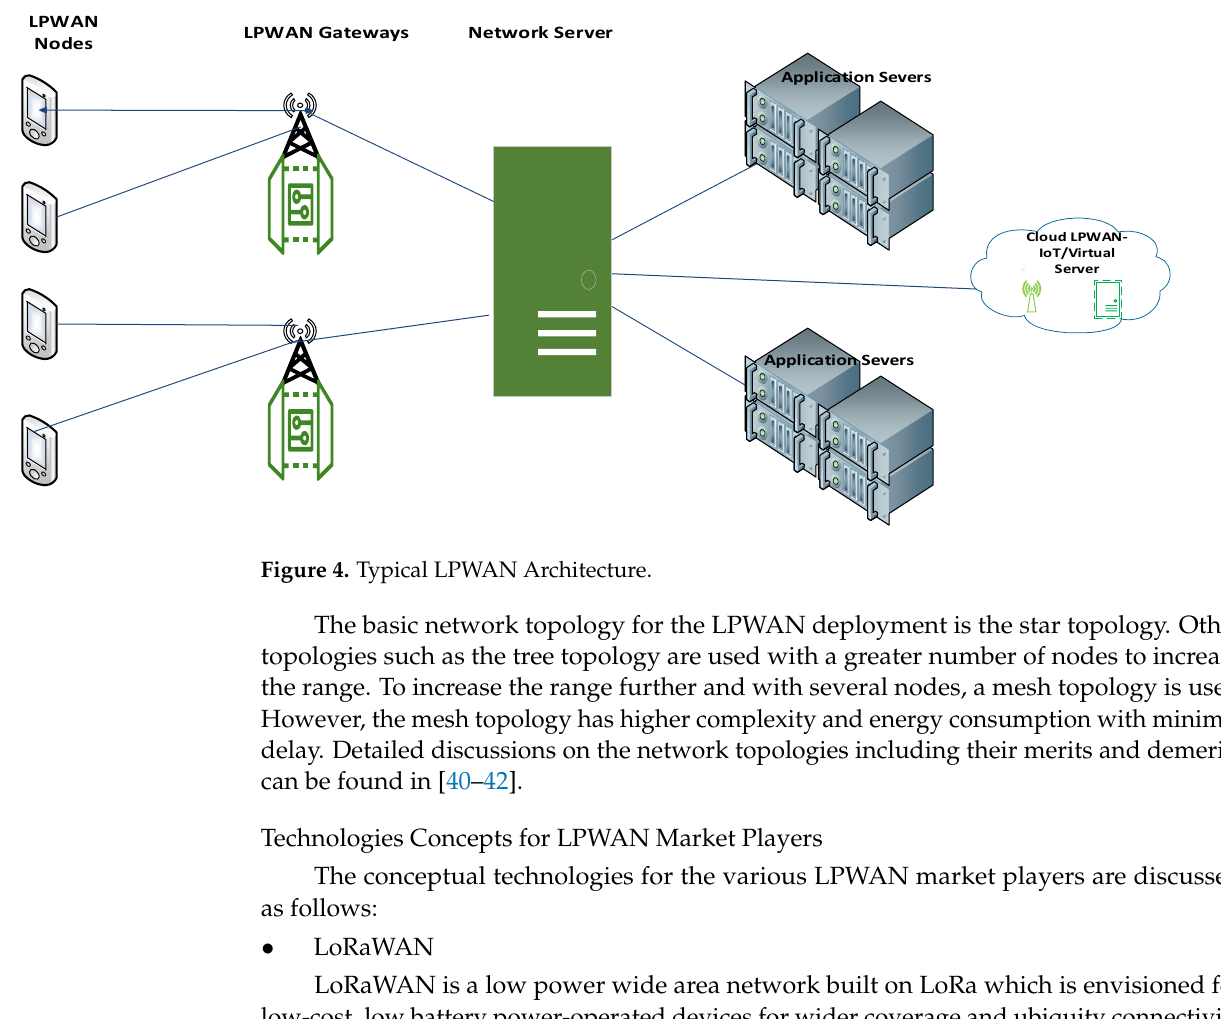
Figure 3. Seven-Layer IoT Architecture (adapted from [37]).